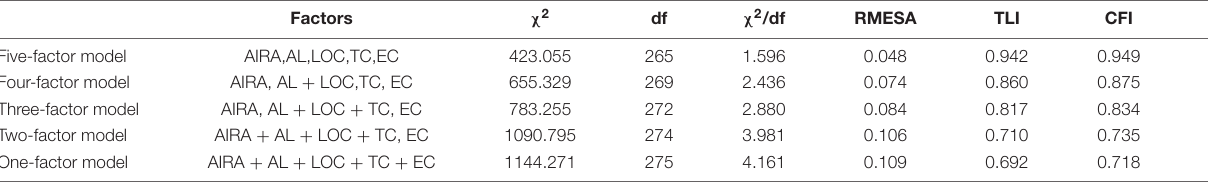
TABLE 3 | Results of confirmatory factor analysis (CFA).